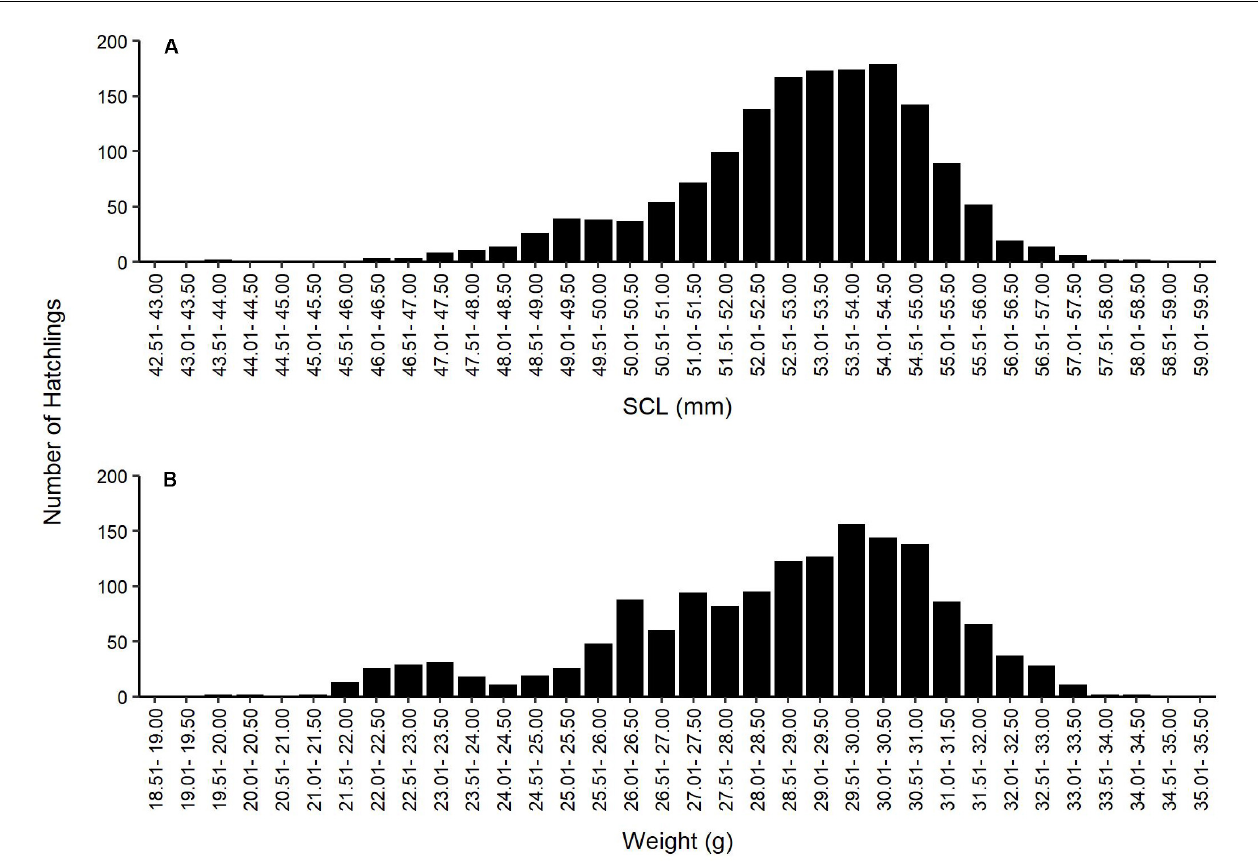
FIGURE 4 | (A) Straight carapace lengths (SCL) (mm) and (B) weights (g) measured for green turtle ( Chelonia mydas ) hatchlings that emerged from eggs hatched at the Padre Island National Seashore (PAIS) incubation facility, and released on the beach at PAIS, from 1987 to 2006.